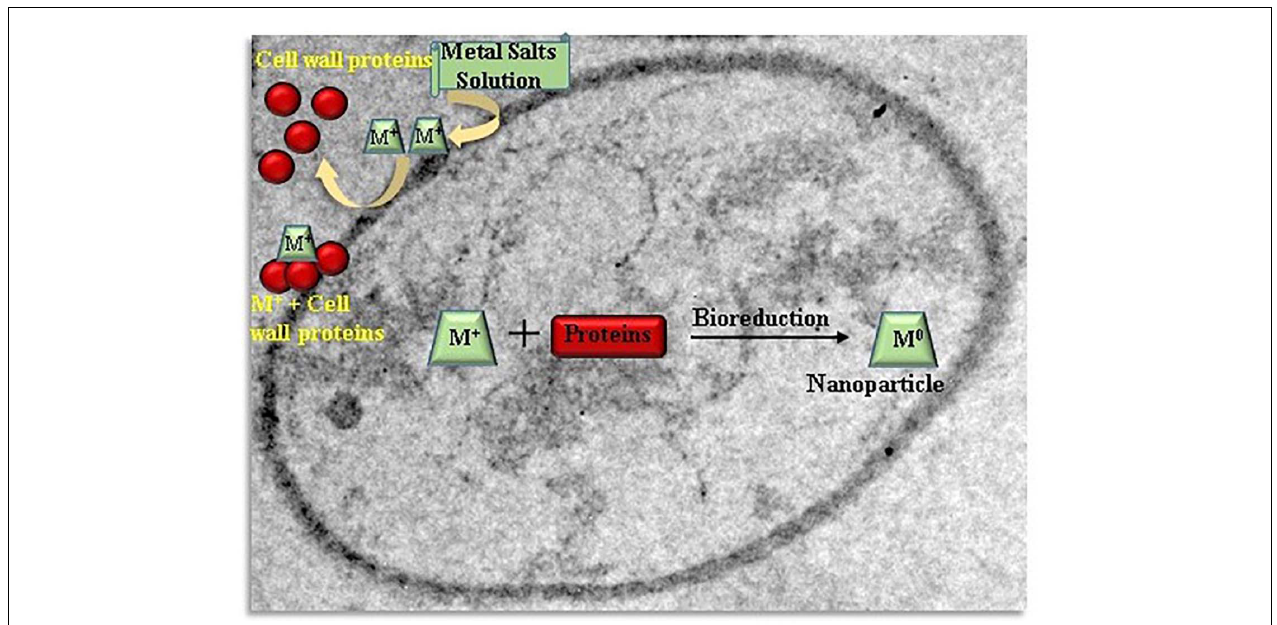
FIGURE 3 | Schematic illustration of the mechanism of intracellularly nanoparticles formation by